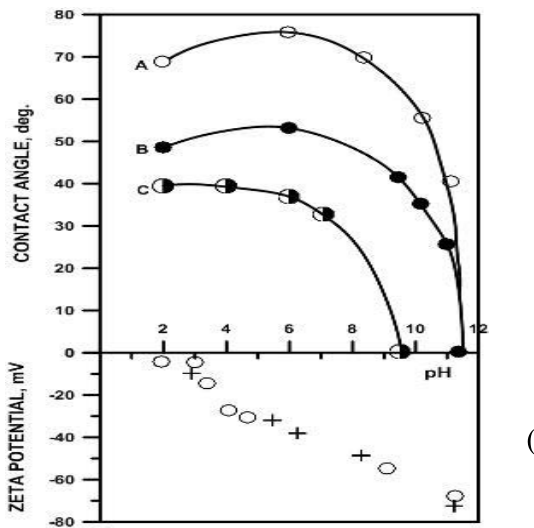
Fig. 2 Effect of pH and pre-treatment on contact angle of methylated silica. (A) Silica coated in 0.04 M trimethyl chlorosilane solution; (B) Silica coated in 0.001 M solution; (C) Silica heated at 450 ℃ for 20 hrs before coating in 0.001 M solution. Bottom part: (o) Methylated hydrophobic silica; ( + ) Pure hydrophilic silica [after Laskowski and Kitchener (1969) 6)